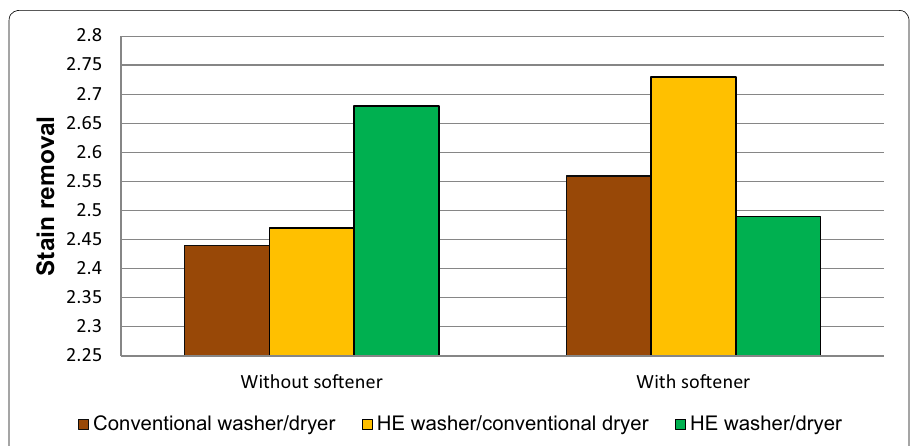
Fig. 2 Stain removal without and with a dryer sheet softener. A smaller number indicates better perfor‑ mance of stain removal (i.e., more color change; more stains removed)